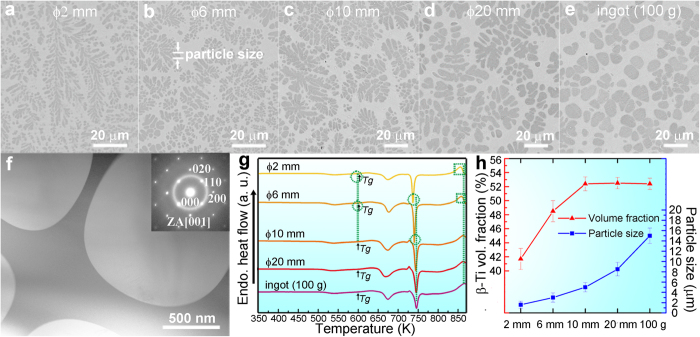
Characterizations of the samples of BT48 obtained at different cooling rates.(a–e) The back-scattered scanning electron microscopy (SEM) micrographs of the as-cast rods with diameters of 2 mm, 6 mm, 10 mm, and 20 mm, and the ingot of 100 g, respectively. The different cooling rates have a strong influence on the volume fractions, the shapes, and the size of β-Ti. (f) The transmission electron microscopy (TEM) micrograph of the rod with a diameter of 6 mm with an inset of diffraction pattern from the two-phase interface, showing a two-phase microstructure containing a glassy matrix and β-Ti with a body-centered cubic () symmetry. (g) Differential scanning calorimetry (DSC) traces of the samples. The differences between the rods with a diameter of 2 mm or 6 mm and other samples are marked by circles (arising from the glassy matrices) and rectangulars (arising from β-Ti), indicating the compositions of both phases in the rods with a diameter of 2 mm or 6 mm are slightly different with other samples. The exothermic events at about 540 K before Tg arise from the metastable β-Ti. (h) The summary of the measured volume fractions and particle sizes (herein refer to the diameters of the secondary arms, as shown in (b)) of β-Ti in different samples. Error bars (s.d.) of the fluctuations of the measured volume fractions and particle sizes of β-Ti are given. Although particle sizes increase with lowering the cooling rates, the volume fractions of β-Ti are identical in the rods with diameters of 10 mm, and 20 mm, and the ingot of 100 g.